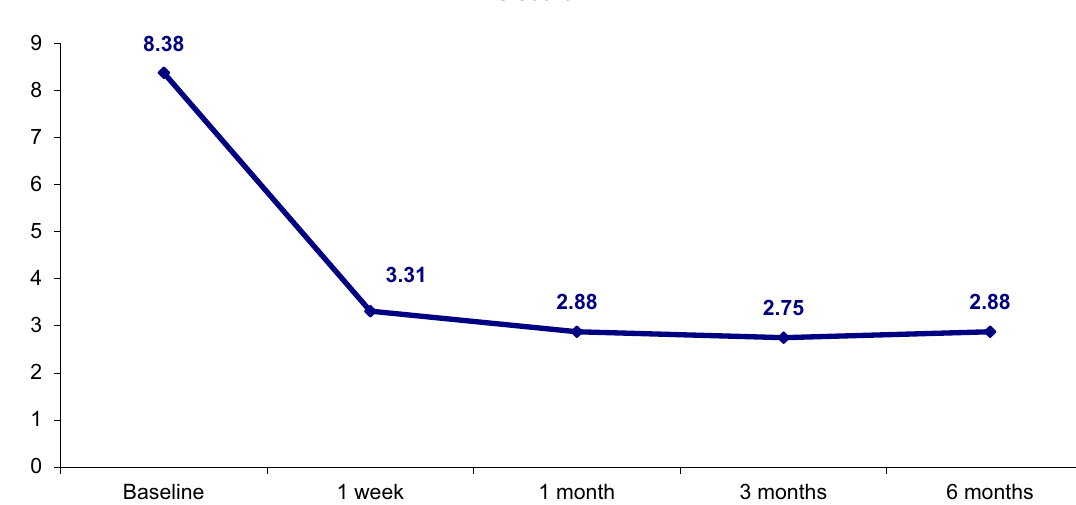
Fig. 4 The previous graph illustrates the relationship of VAS score in relation to time (at baseline and at 1 week, 1, 3 and 6 months post-embolization follow up) with the maximum improvement in the VAS score from the baseline and 1 week after embolization